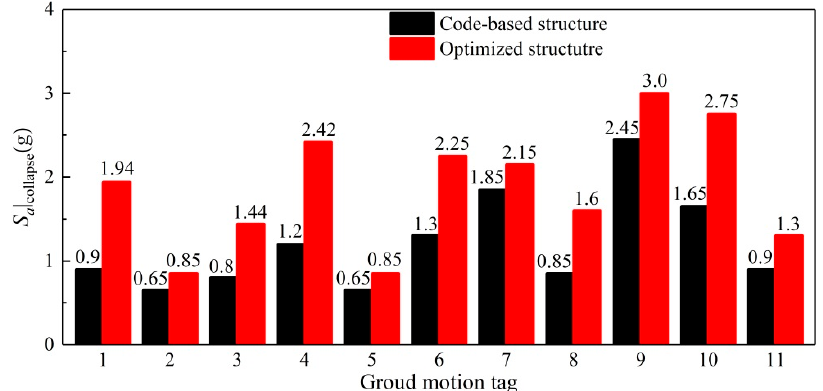
Figure 10. Comparison of the seismic collapse capacity of code-based and optimized structure.